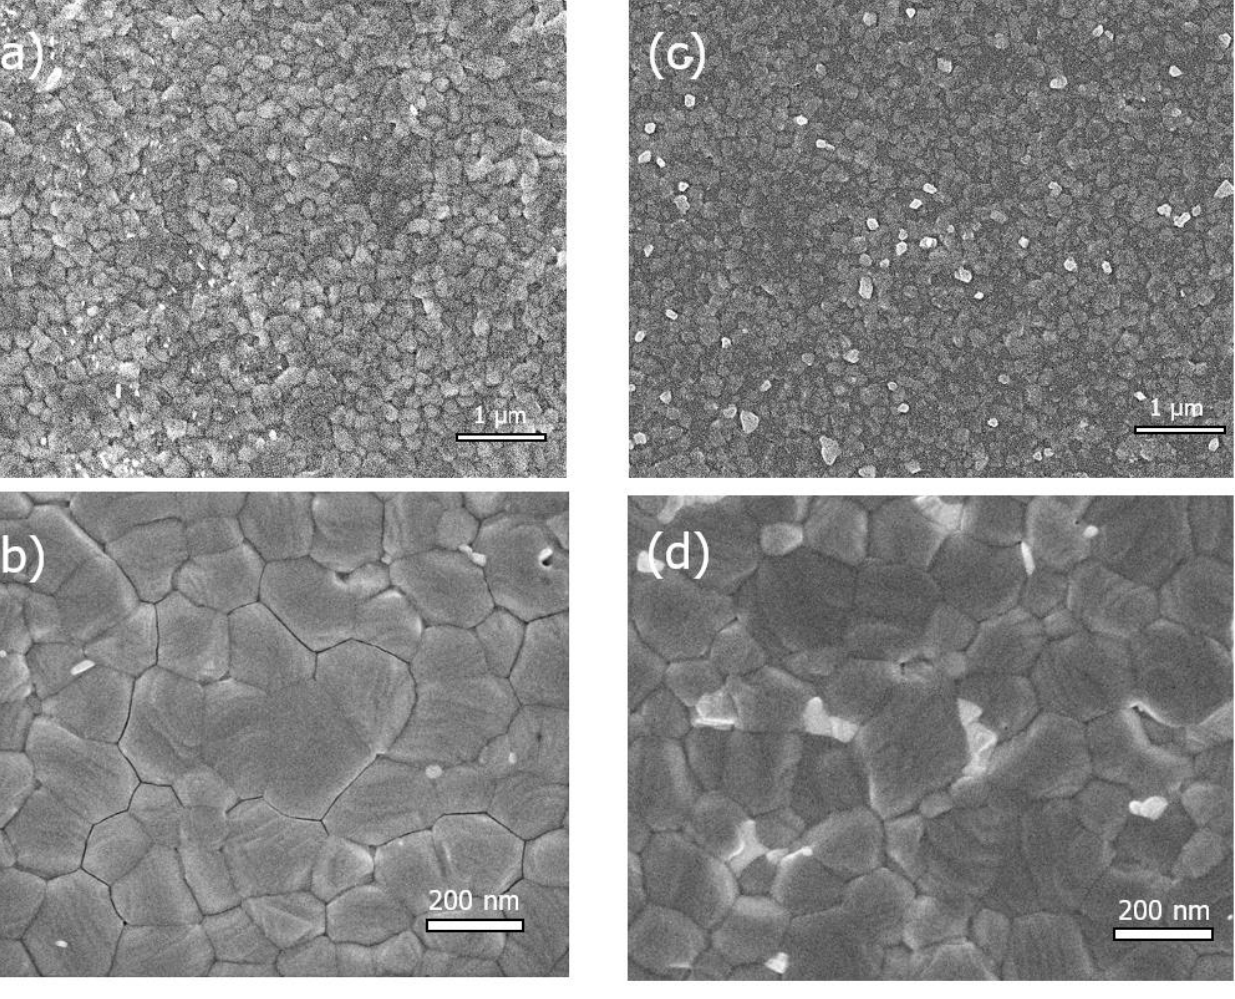
Figure 3. Photographs of FE-SEM observation of perovskite structures. ( a , b ) FTO/TiO 2 (CBD method)/perovskite (one-step method); ( c , d ) FTO/TiO 2 (CBD method)/perovskite (two-step method).